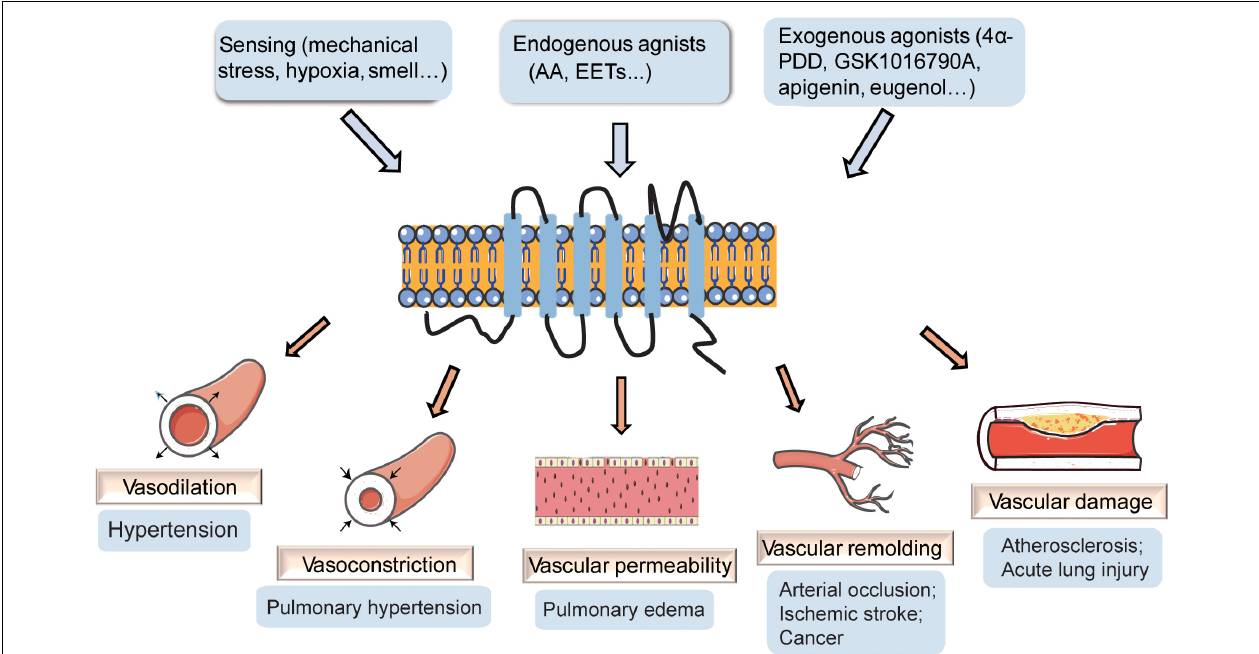
FIGURE 1 | The effect of transient receptor potential vanilloid 4 (TRPV4) on vasculature. TRPV4 channels can be activated by stimuli-sensing, endogenous agonists, and exogenous agonists. The activation of TRPV4 participates in the regulation of vascular dilation and constriction, vascular permeability, vascular remolding,